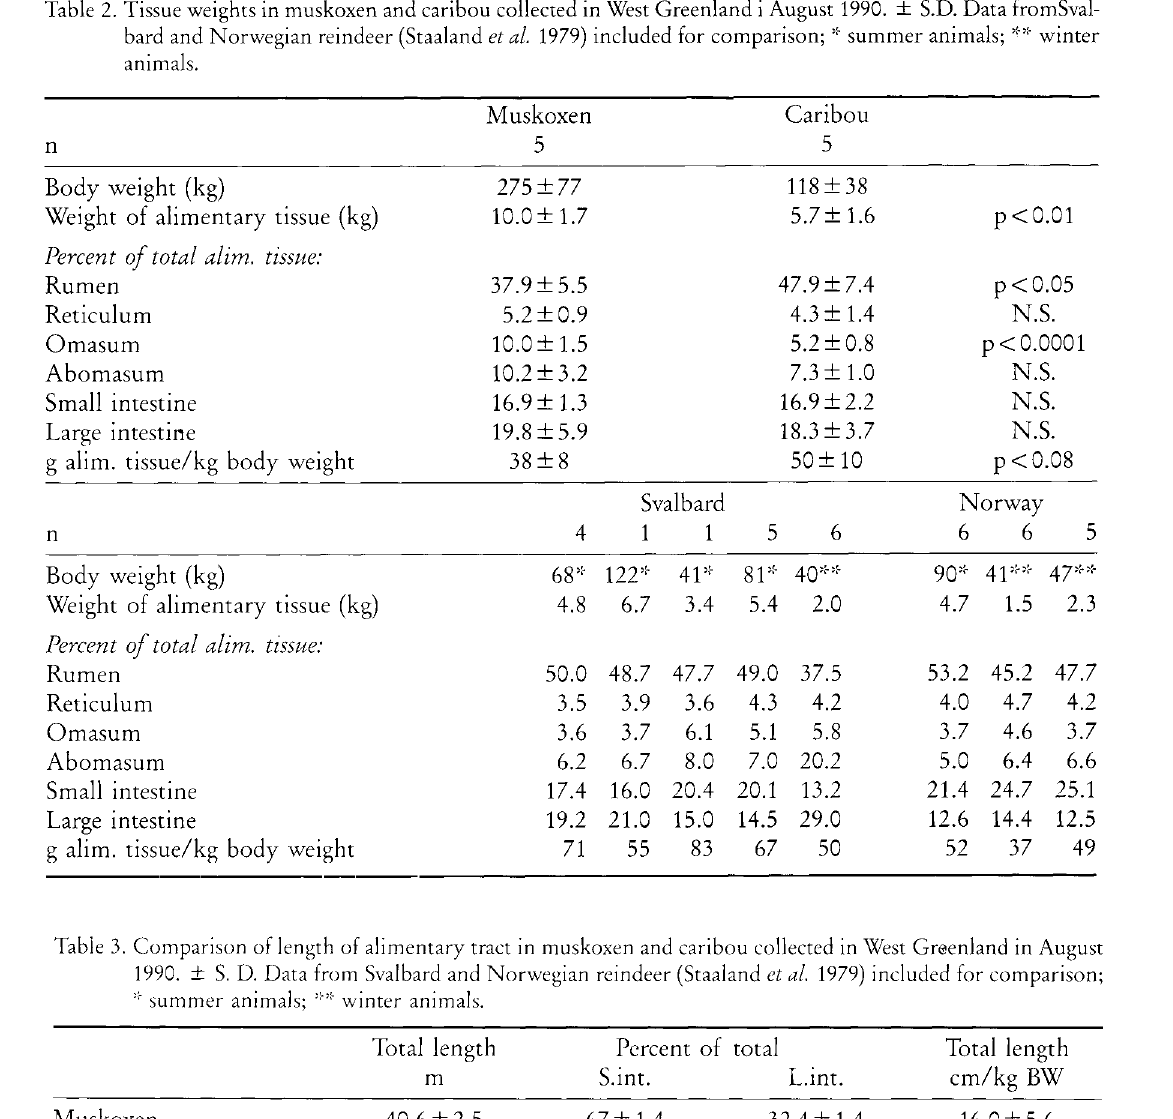
Table 2. Tissue weights in muskoxen and caribou collected in West Greenland i August 1990. ± S.D. Data fromSval- bard and Norwegian reindeer (Staaland et al 1979) included for comparison; * summer animals; ** winter animals.